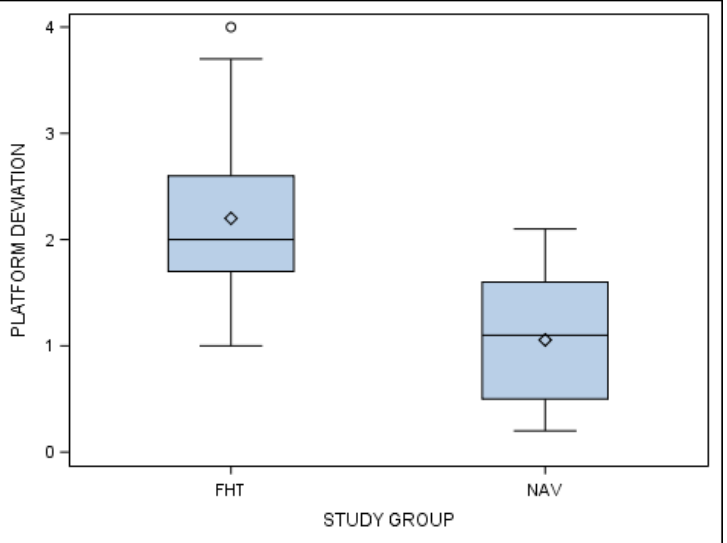
Figure 4. Box plot of the coronal deviations in planned and performed orthodontic micro-screws between computer-aided static navigation technique and conventional freehand technique study groups. Table 2. Descriptive deviation values at coronal entry-point (mm) of the orthodontic micro-screws placed by using conventional freehand technique and computer-aided static navigation technique study groups in the incisive–canine, premolar and molar dental sector.